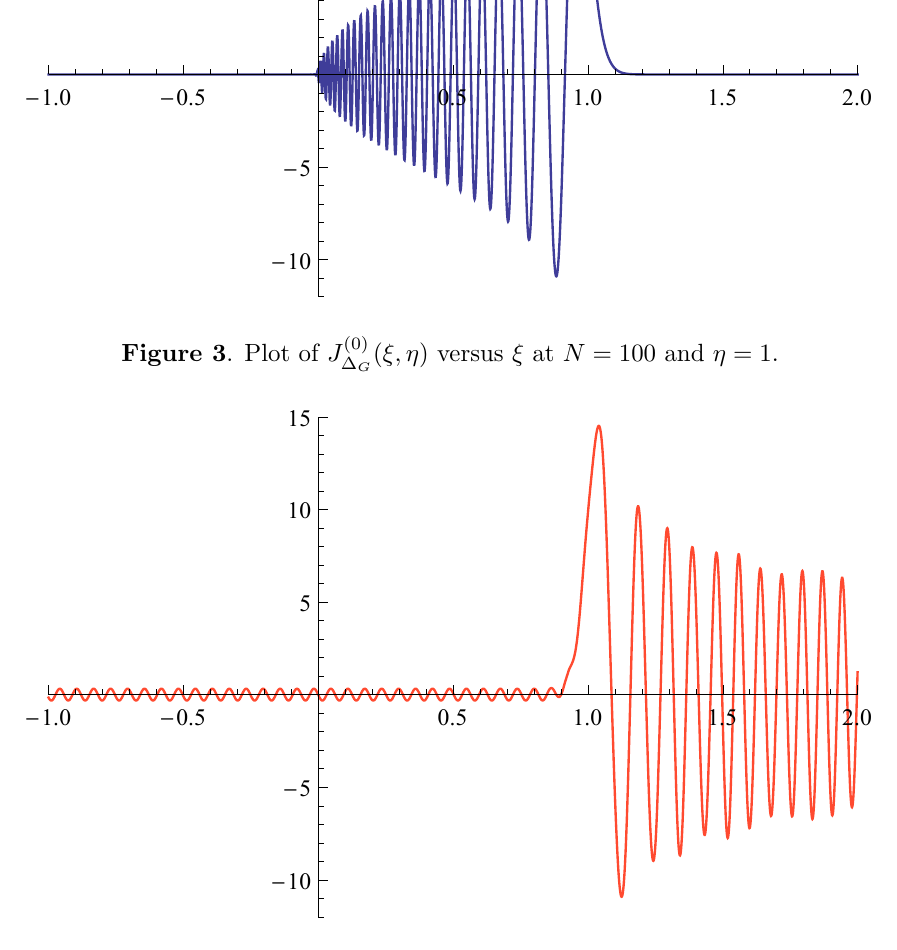
Figure 4 . Plot of J (0) ( (cid:24); (cid:17) ) versus (cid:24) at N = 100 and (cid:17) = (cid:1) s